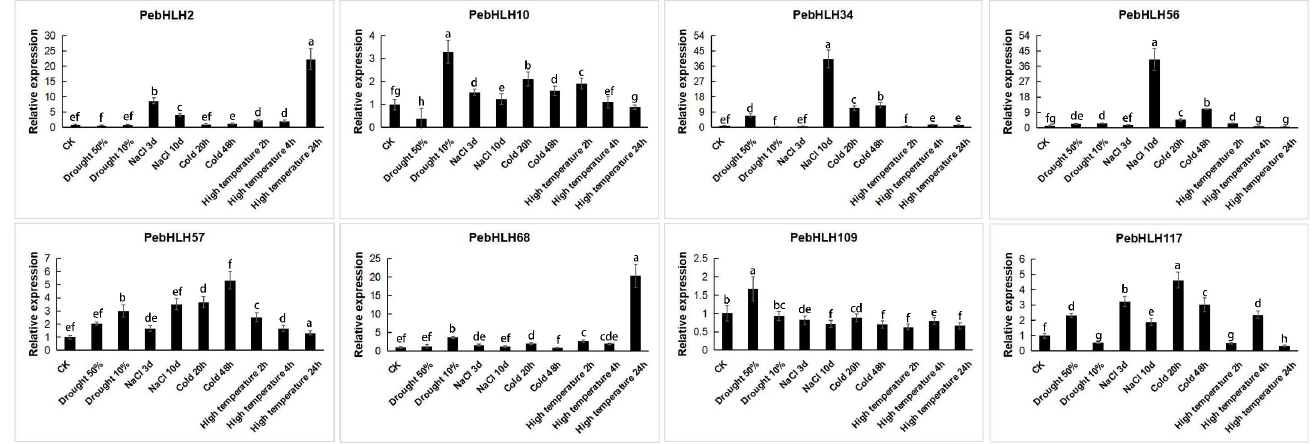
Figure 7. Differential expression of PebHLHs responding to different levels of drought, high salt, cold, and high temperature (Table S2). CK is normal growth condition, drought 50% and 10% are soil water content indexes, NaCl 3 d and 10 d are the treatment time under 300 mM concentration, cold 20 h, and 48 h are the treatment under 8 °C, and high temperature 2 h, 4 h, and 24 h are the treatment time under 42 °C, respectively.